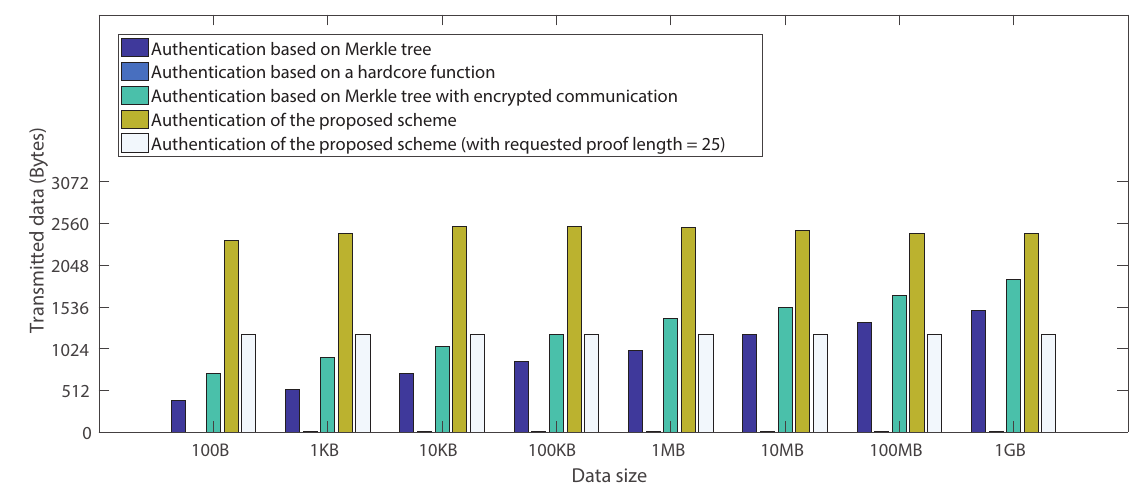
Figure 11. Comparison of trasmitted data on prover side with varying data